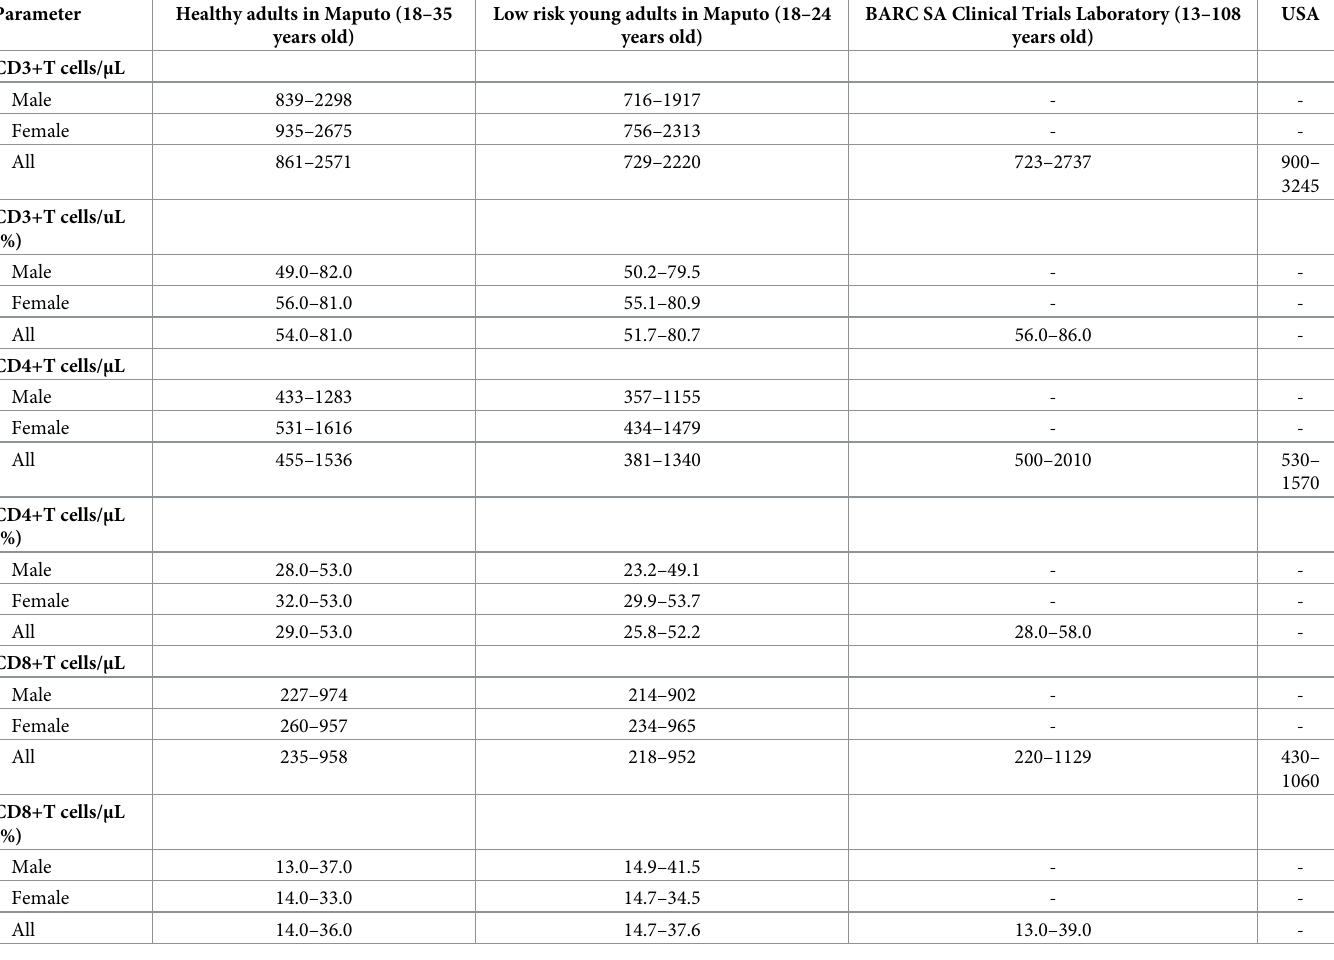
Table 4. Lymphocytes subset reference values from healthy adults at high-risk for HIV in Mozambique compared with local (low risk healthy adults), regional (SA) and international countries (USA). Parameter